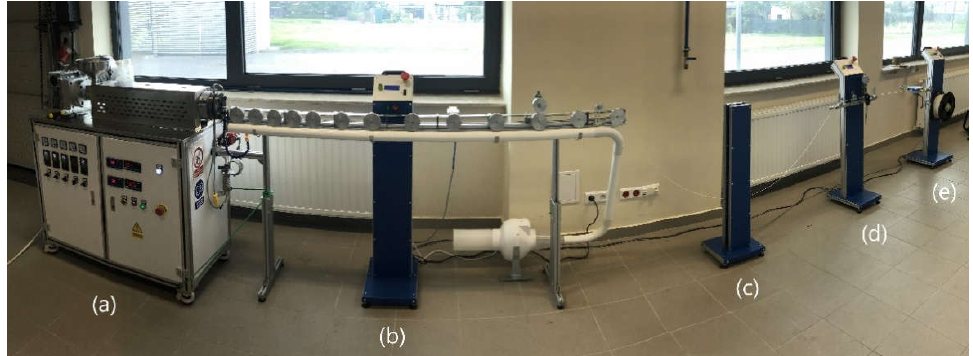
Figure 1. Proprietary technological line for filament production: ( a ) view of a single-screw extruder with a hopper, ( b ) view of an air-cooled roller extractor with a control panel, ( c ) filament extraction speed sensor system, ( d ) filament diameter measurement section, and ( e ) winder with control panel.